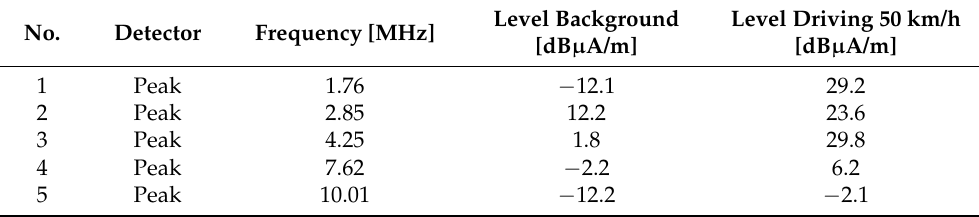
Table 3. Measurement method and the results obtained for individual frequency ranges for a rail vehicle travelling at a speed of 50 km/h, and the OETD electromagnetic background level.